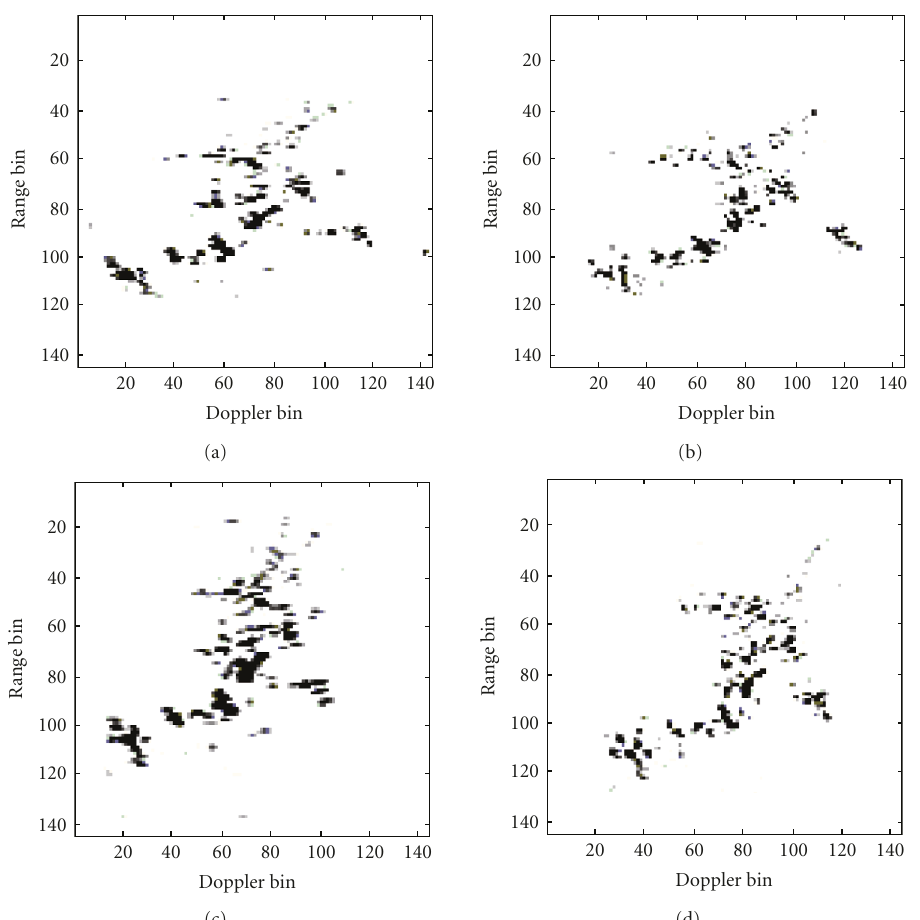
Figure 4: ISAR images of Yak-42: (a) chirplet decomposition, (b) MACD, (c) chirplet decomposition, and (d) MACD.